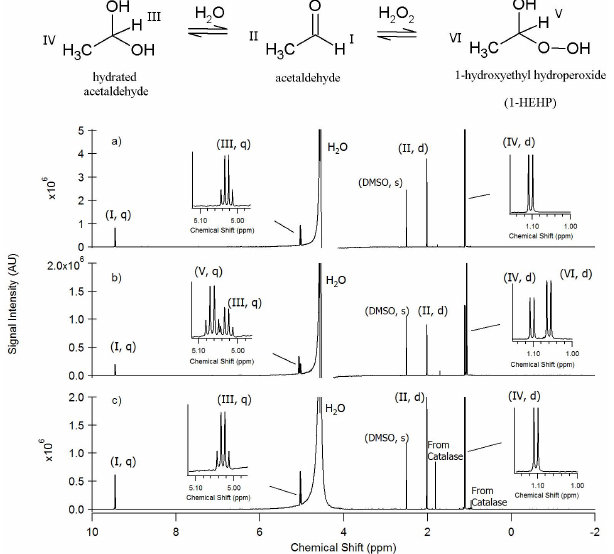
Fig. 3. 1 H NMR spectra for acetaldehyde. (a) Acetaldehyde aque- ous solution; (b) 17.7mM of H 2 O 2 was added to the acetaldehyde solution; (c) catalase was added to the solution to quench H 2 O 2 . The insets are the magnified view of certain regions of the spec- tra. The split pattern and the identity of each peak are shown in the brackets (the numbers match those in the chemical structures).